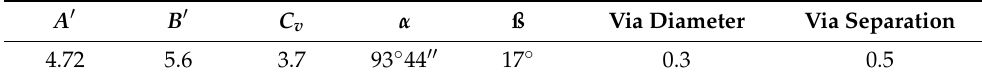
Figure 2. The top-view of the proposed CP antenna, modeled in Ansys HFSS-2021 simulator. Table 1. Geometrical parameters of the proposed antenna element (mm).